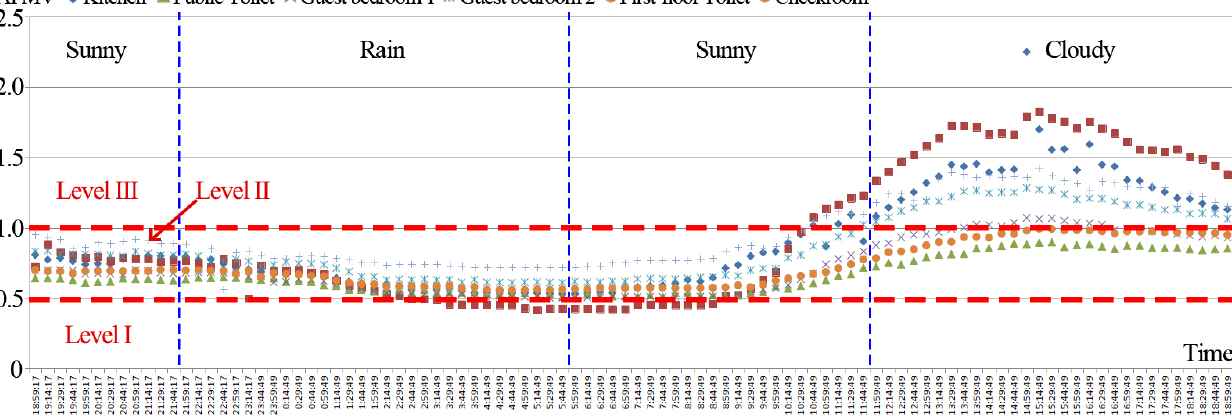
Table 4. Non-artificial heat- and cold-sourced heat and humidity environment evaluation index.